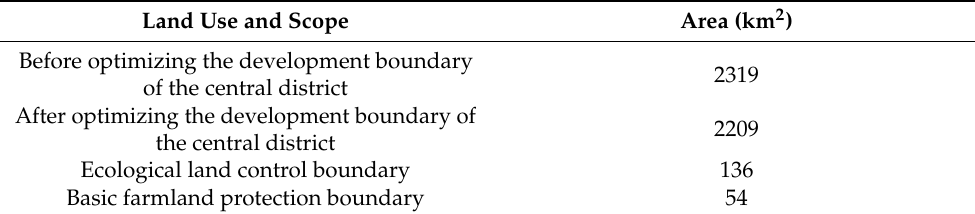
Table 9. Comparisonofthedevelopmentboundaryofthecentraldistrictareabeforeandafteroptimization.